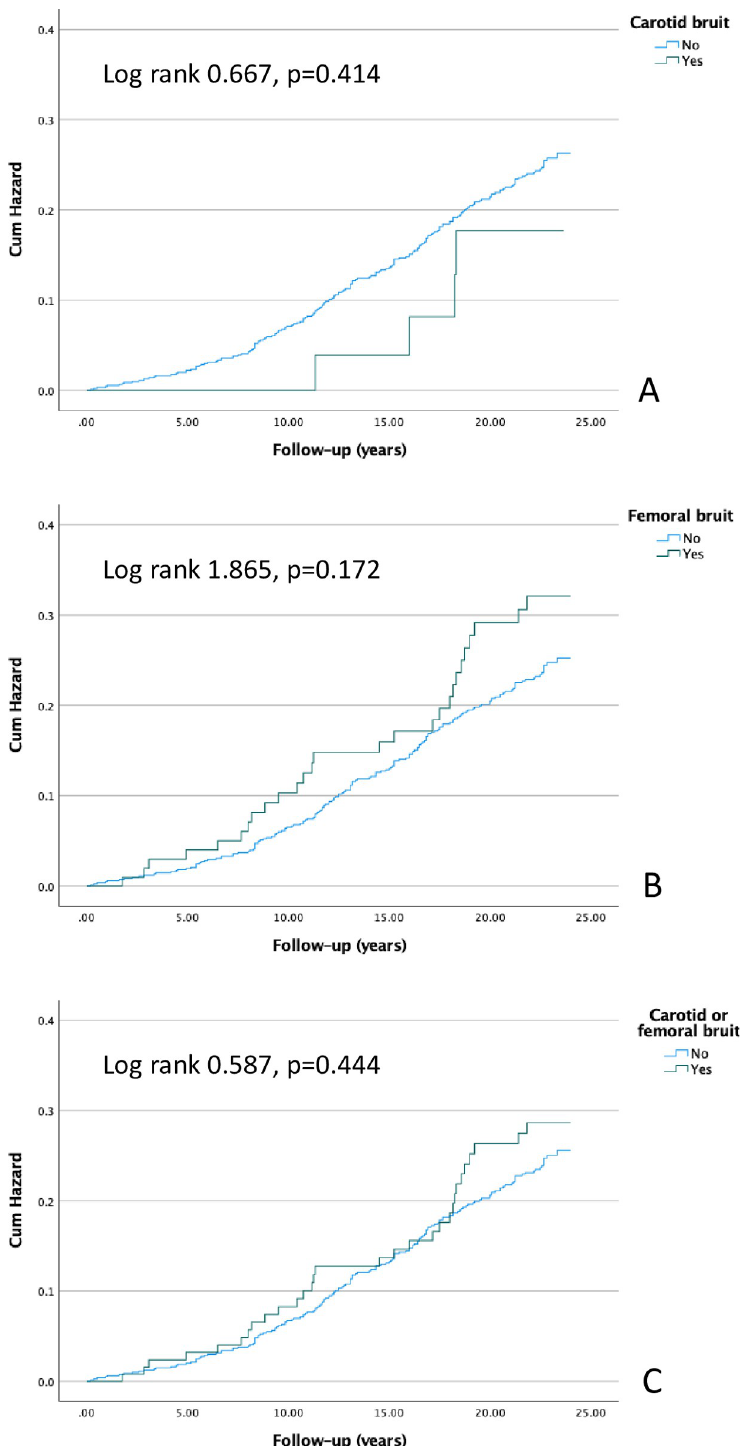
Fig 4. Kaplan-Meier curves presenting the cumulative hazards for cardiovascular events in patients with carotid bruit (A), femoral bruit (B), and carotid or femoral bruit (C).